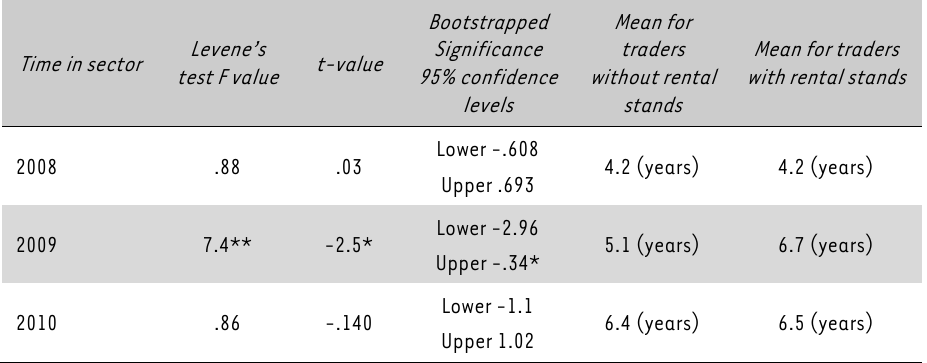
TABLE A3: Results of the t-tests for differences in Time in the Sector Time in sector